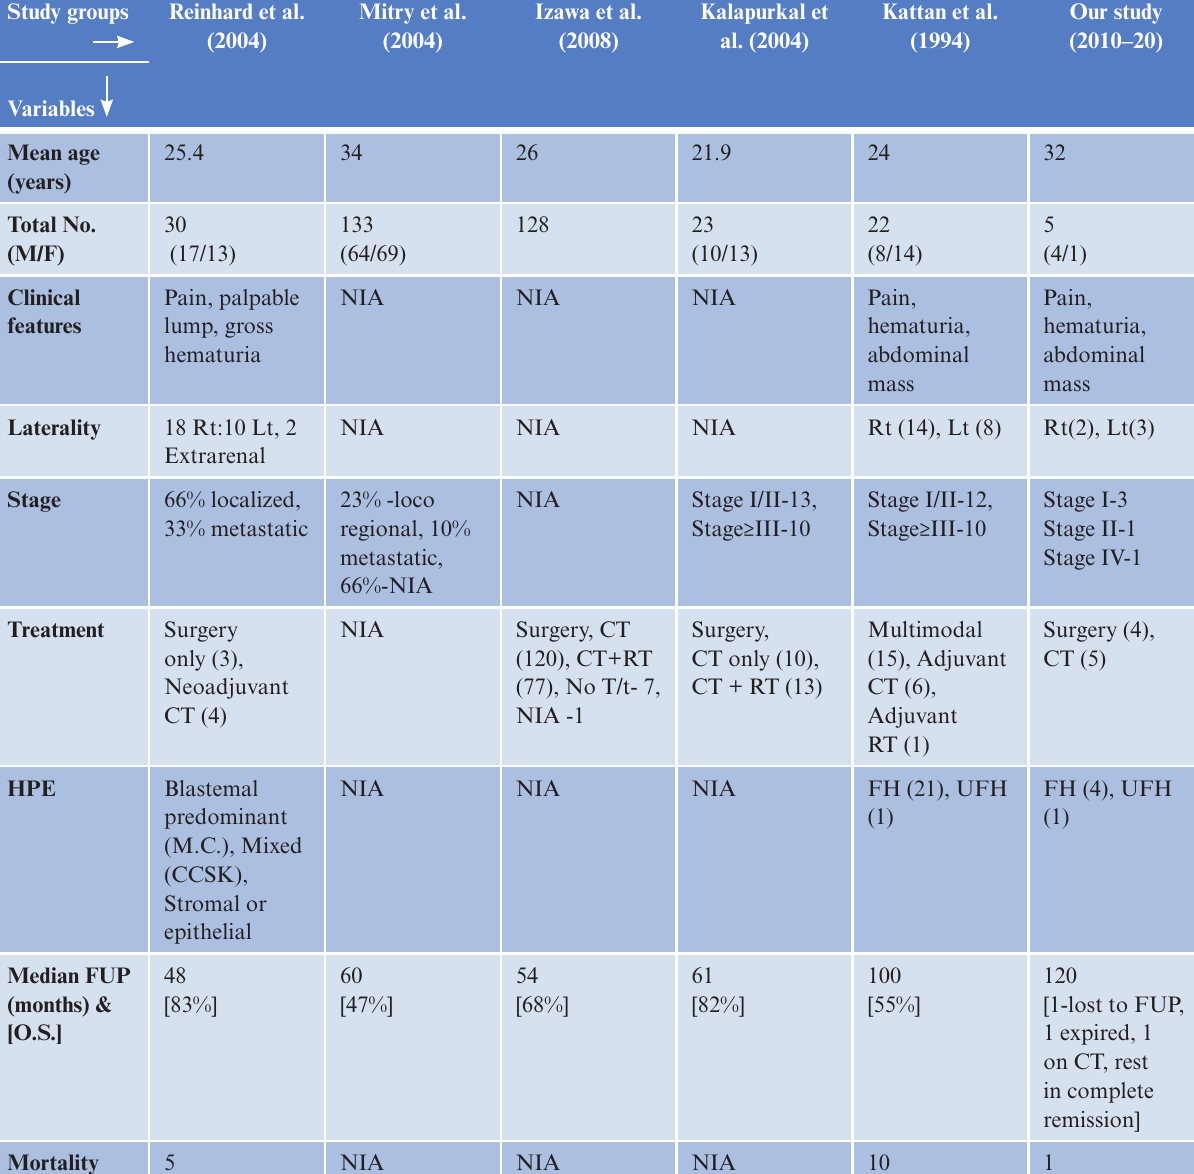
Table 3: Review of literature illustrating comparable clinicopathological treatment and outcome variables. Study